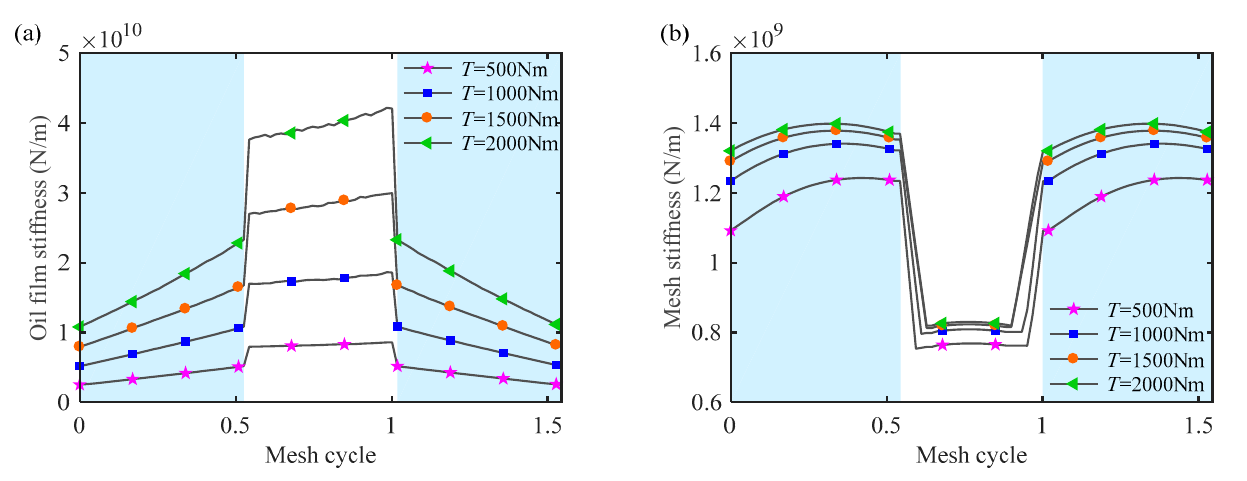
Figure 15. OFS and TVMS of gear under different torque: ( a ) OFS; ( b ) TVMS.